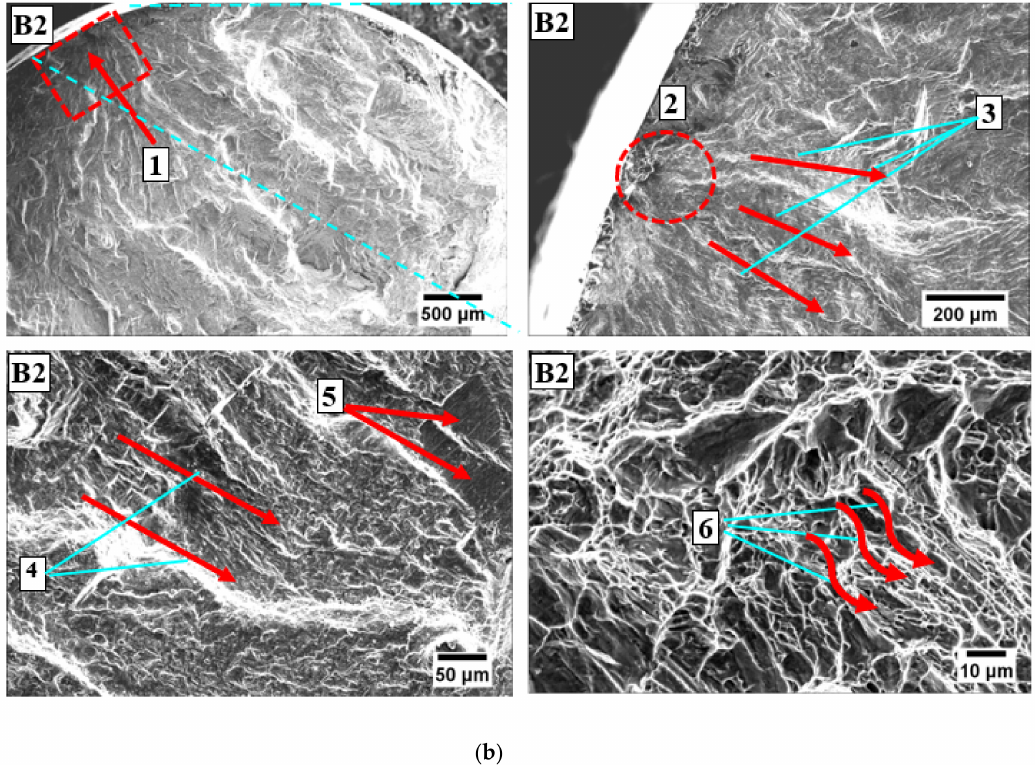
Figure 5. SEM fractography images of Ti-6Al-4V ELI for ( a ) MA, note: 1—crack initiation point, 2—crack initiation, 3—slow crack propagation, 4—fast crack propagation, 5—fine equiaxed dimples and ( b ) B2 ( β -solution treatment (1035 ◦ C / 1 h, WQ) + aging (600 ◦ C / 2 h, AC) + DCT ( − 196 ◦ C / 24 h) + tempering (170 ◦ C / 4 h, AC)), note: 1—crack initiation point, 2—crack initiation, 3—slow crack propagation,